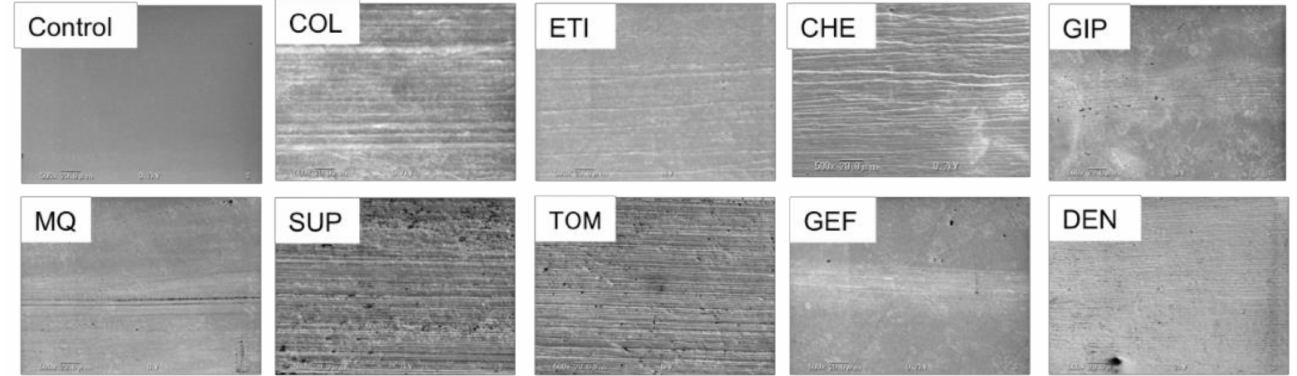
Figure 5. SEM images of titanium disc surfaces brushed with MQ or toothpastes and an unprocessed titanium disc (control), magnification of 500 ×